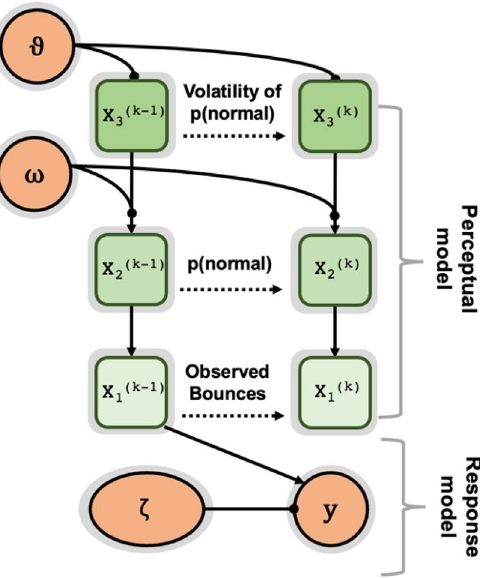
Figure 4. Schematic of three level HGF model. Level x 3 corresponds to perceived volatility of the evolving beliefs about the probability of normal/bouncy at x 2 . The relationship between beliefs at x 2 and decisions over action are described by the sigmoid transformation of x 2 at x 1 . Parameters ϑ and ω determine the variance in the Gaussian random walk for their respective levels. In the absence of perceptual uncertainty, as is the case here, x 1 simply corresponds with observations (u). Time steps are denoted by